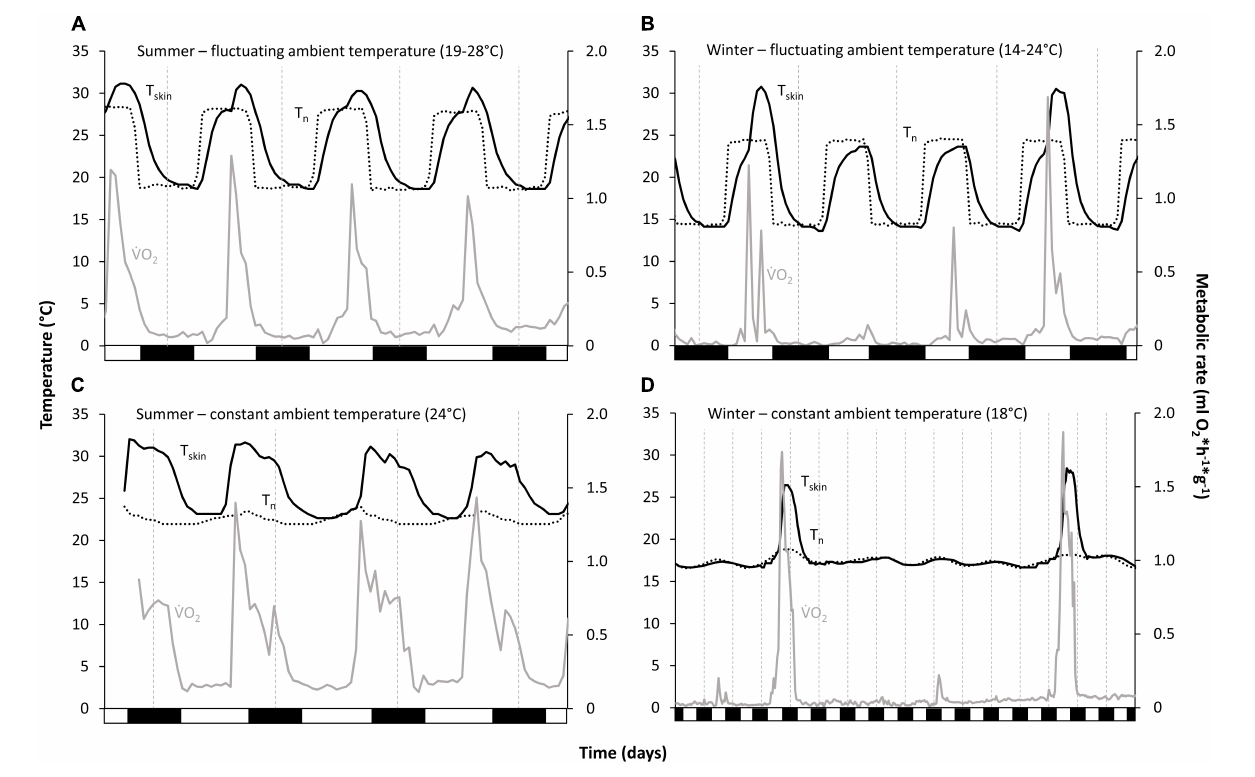
FIGURE 1 | Torpor and arousal/activity phase pattern of Echinops telfairi for four experimental treatments. (A,B) fluctuating temperature conditions (summer and winter), (C,D) constant temperature conditions (summer and winter). Tenrecs became torpid every day; under fluctuating temperature conditions, they used these fluctuations for passively warming from torpor until maximum nest box temperature, whereas under constant temperature conditions they had to rely on endogenous heat production. Black line: skin temperature; dotted line: nest box temperature; gray line: metabolic rate; vertical dashed lines indicate midnight, black boxes on the x -axis the